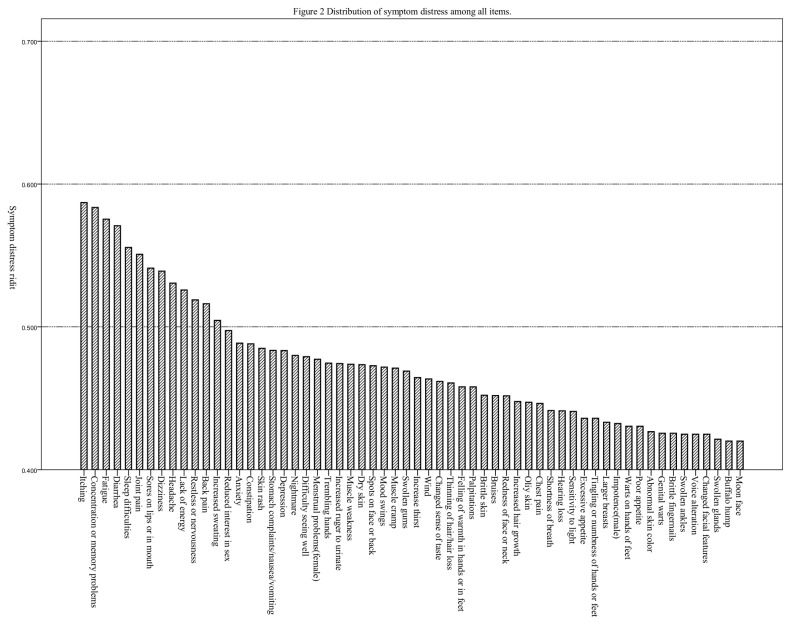
Distribution of symptom distress among all items.